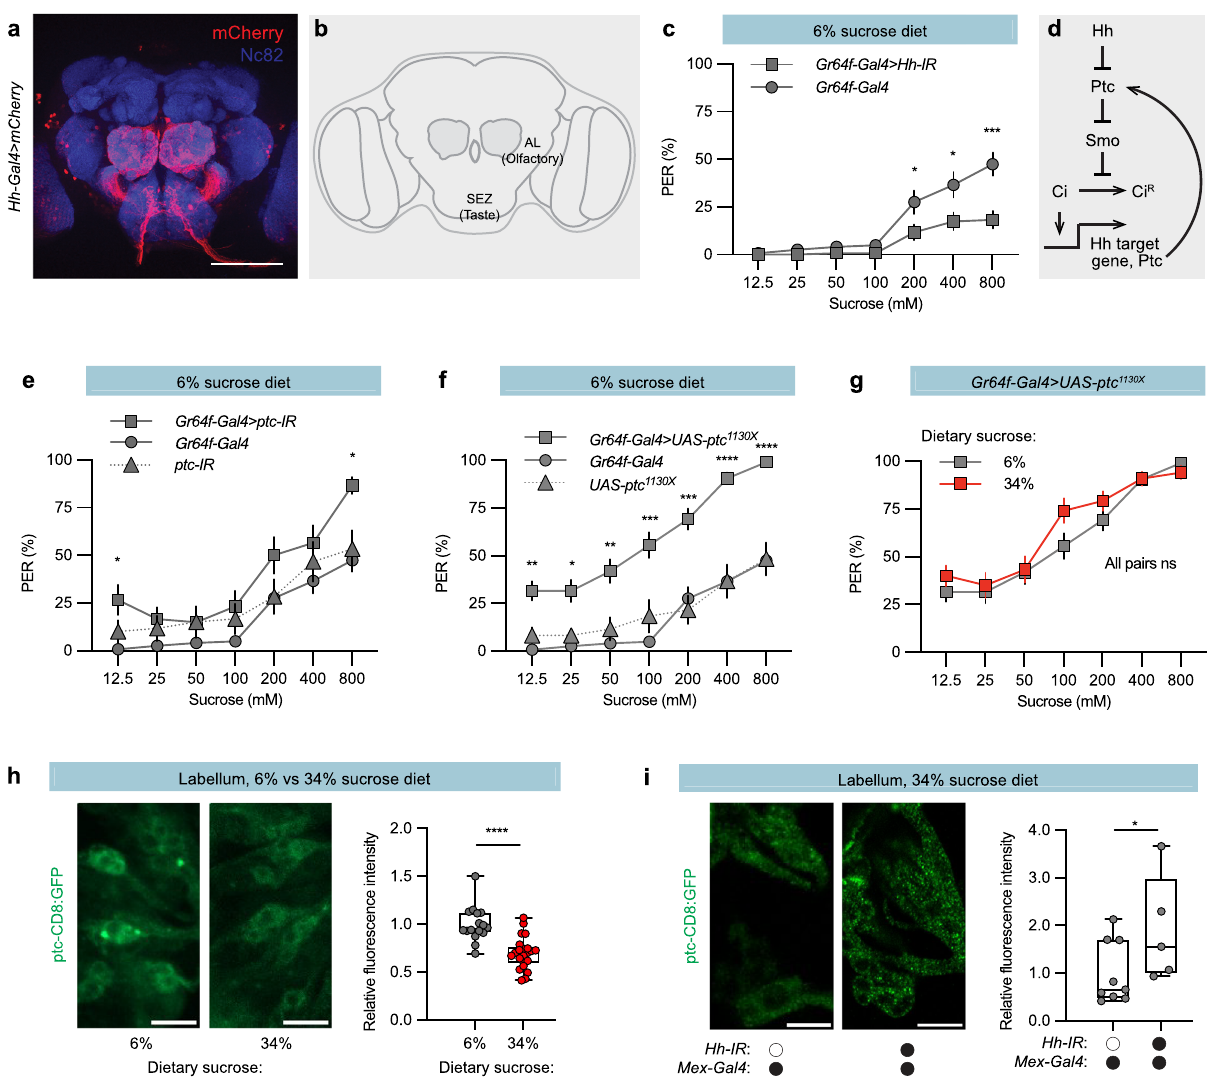
Fig.6|DietarysugarsuppressesautocrineHhsignallinginsweettasteneurons via an endocrine Hh signal. a Expression of Hh-Gal4 ( mCherry ) in a male adult brain. Anti-Nc82 staining is shown in blue. Scale bar, 100 μ m. b Drosophila brain schematic. The antennal lobe (AL) and the suboesophageal zone (SEZ) is the brain regions where olfactory respective taste sensory neurons connect to their projec- tion neurons. c Plot showing reduced PER in Gr64f > Hh-IR fl ies maintained ona 6% sugar diet. d Schematic of the Hh pathway. Hh, Hedgehog; Ptc, Patched; Smo, Smoothened; Ci, Cubitus interruptus; Ci R , cleaved form of Ci, which functions as a transcriptional repressor. e Knock down of the Hh receptor Patched (Ptc) in Gr64f sweet sensory neurons increased the PER. f Expression of a dominant negative version of the Hhreceptor Patched ( Gr64f-Gal4 > Ptc 1130X ) insweet sensory neurons increased the PER. g Gr64f-Gal4 > Ptc 1130X fl ies showed a similar PER % when reared on the indicated sugar diets. h Left, representative confocal images of Drosophila